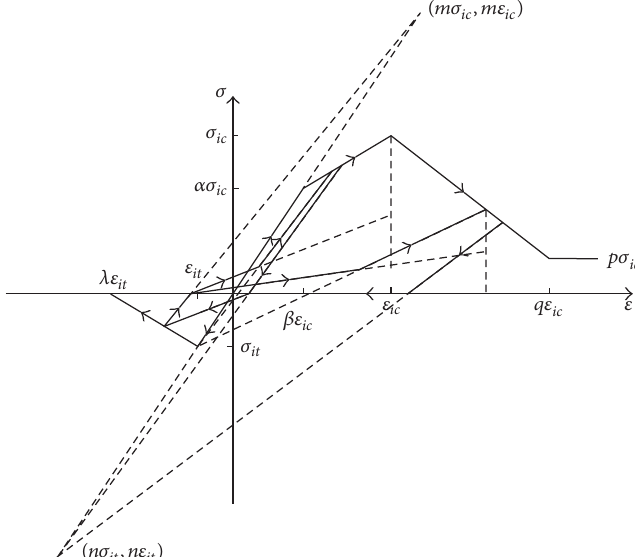
Figure 7: NosaCAD concrete constitutive model.